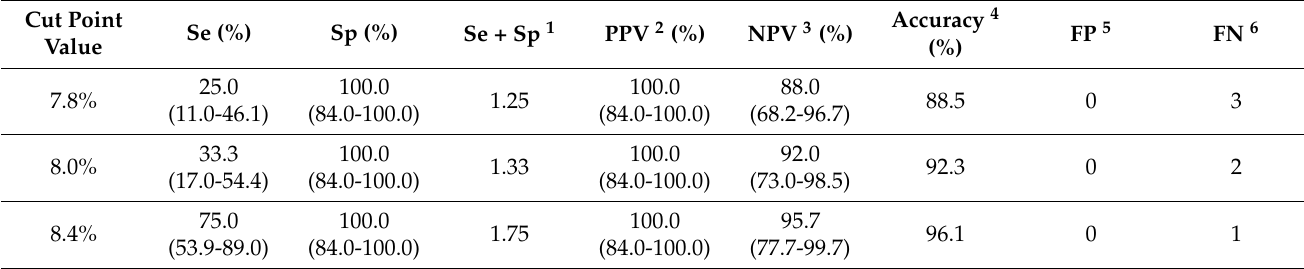
Table 6. Diagnostic test characteristics for serum samples from calves. Sensitivity (Se), specificity (Sp), positive predictive value (PPV), negative predictive value (NPV), accuracy, false positive (FP), and false negative (FN) for different Brix refractometer cut-points compared with 10 mg/mL of IgG as measured by ELISA. Cut Point